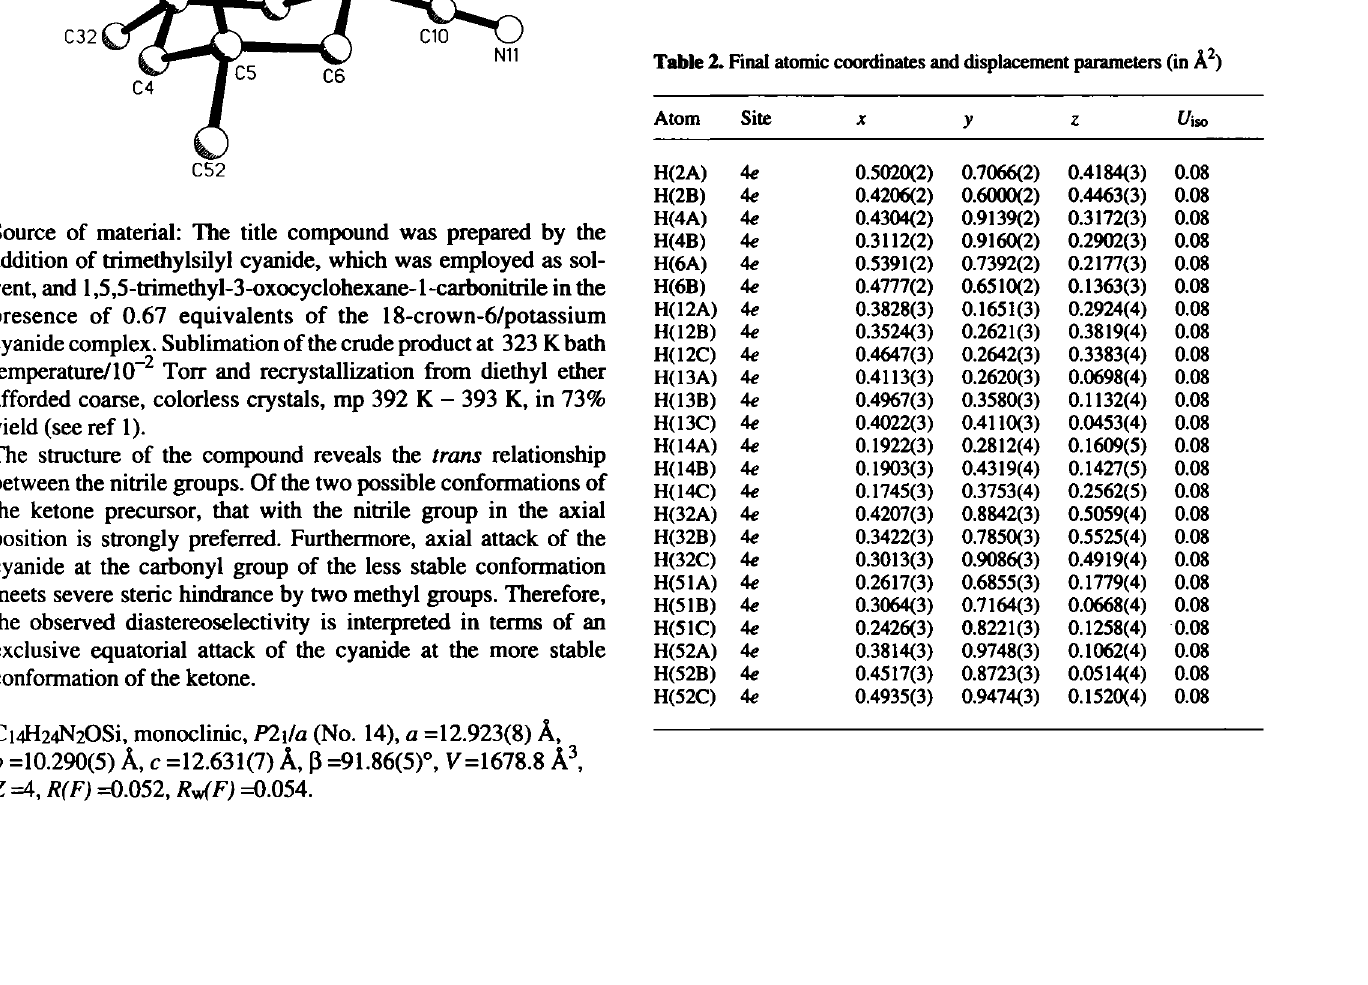
Table 2. Final atomic coordinates and displacement parameters (in